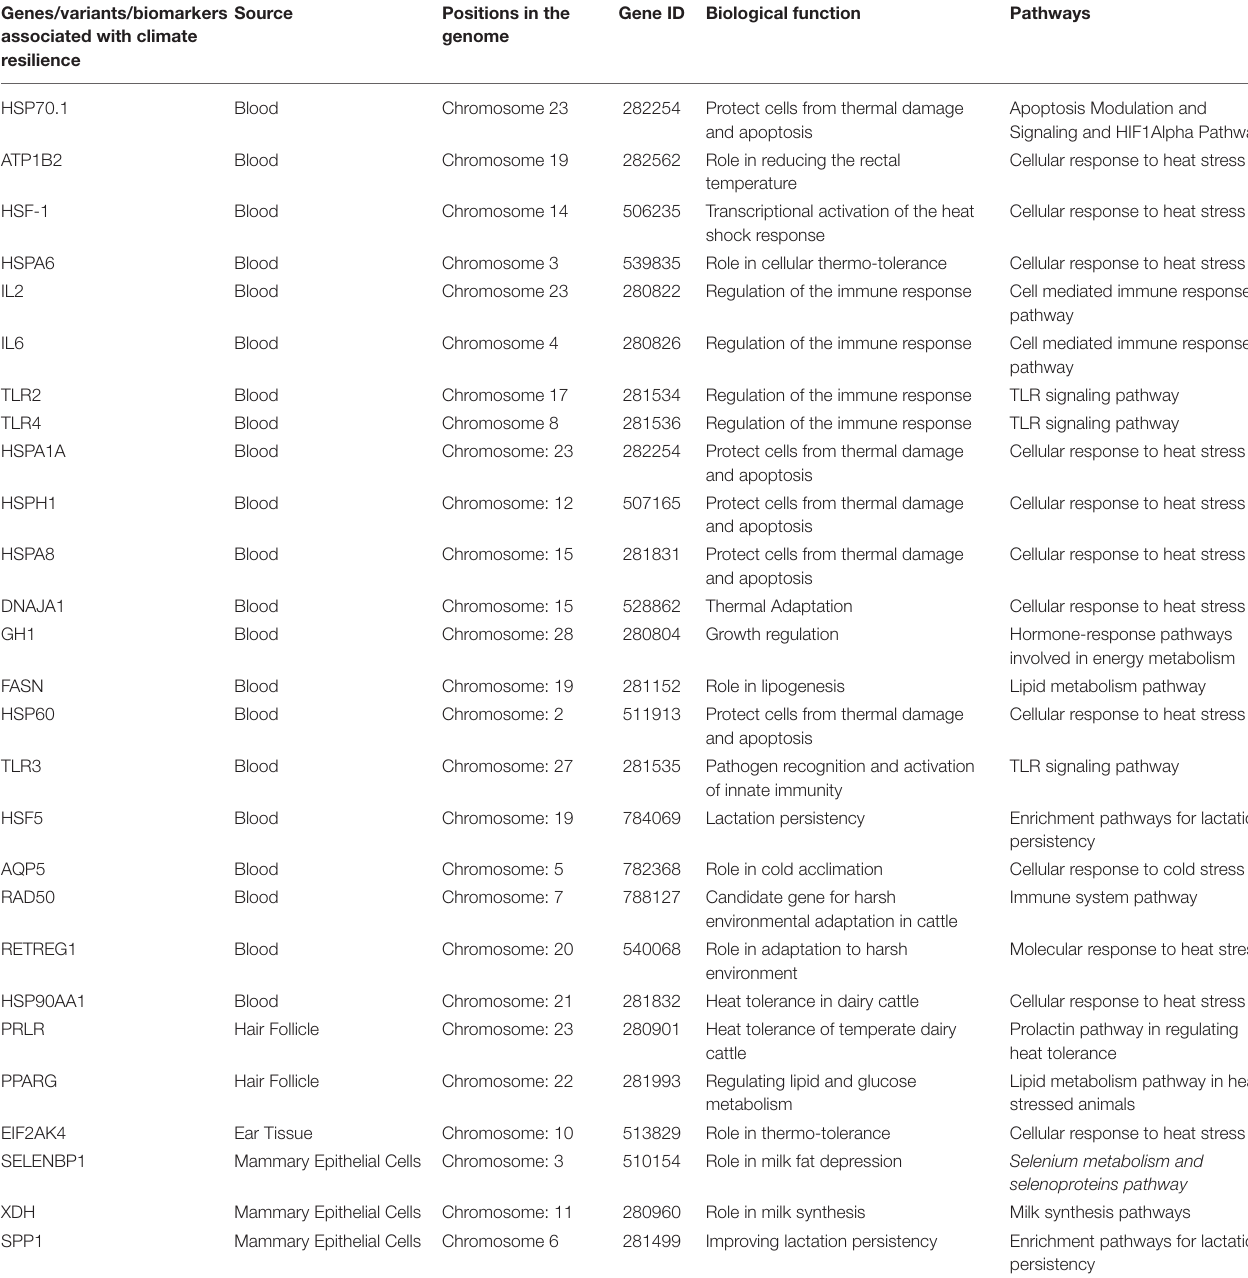
TABLE 3 | Different biomarkers for climate resilience in dairy cattle. Genes/variants/biomarkers associated with climate